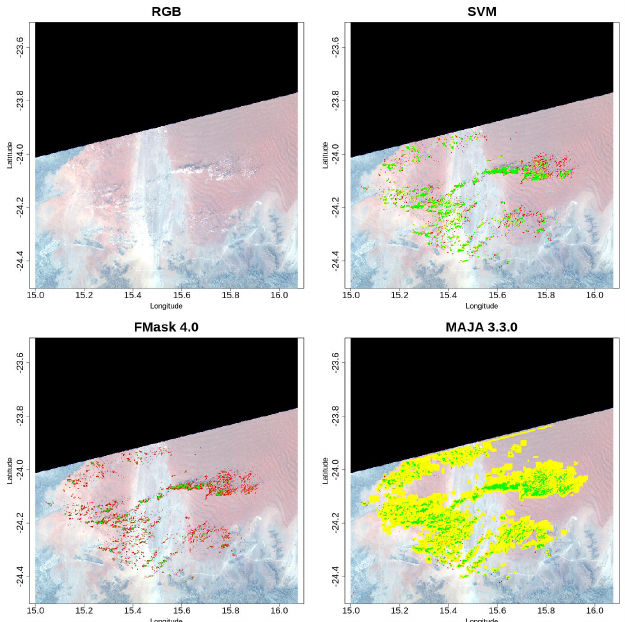
Figure 6. The top left image shows the RGB image from Gobabeb, Namibia, on 9 September 2017. The three other images show the comparison of each procedure (as default) to the reference mask (top-right, SVM, bottom-left, FMask, and bottom-right, MAJA). Green colour corresponds to true positive, red colour to false negative, and yellow to false